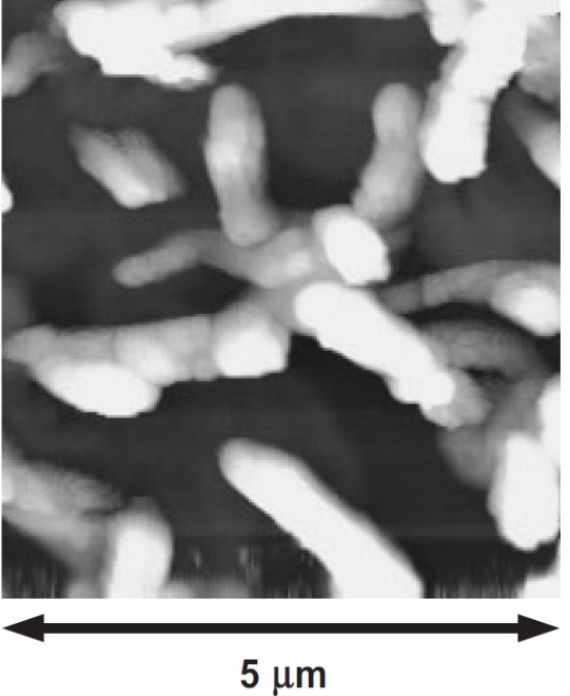
Figure 7. Grain formation of TIPS-pentacene thin film. Reprinted with permission from ref. [52]. 2013 John Wiley and Sons. 2013 John Wiley and